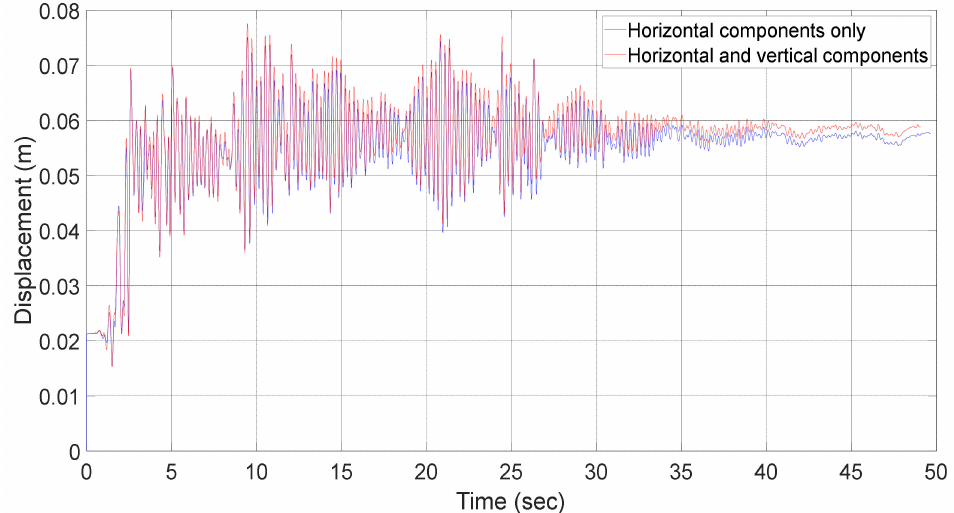
Figure 11. Relative displacement when the horizontal components of the input ground motion are considered